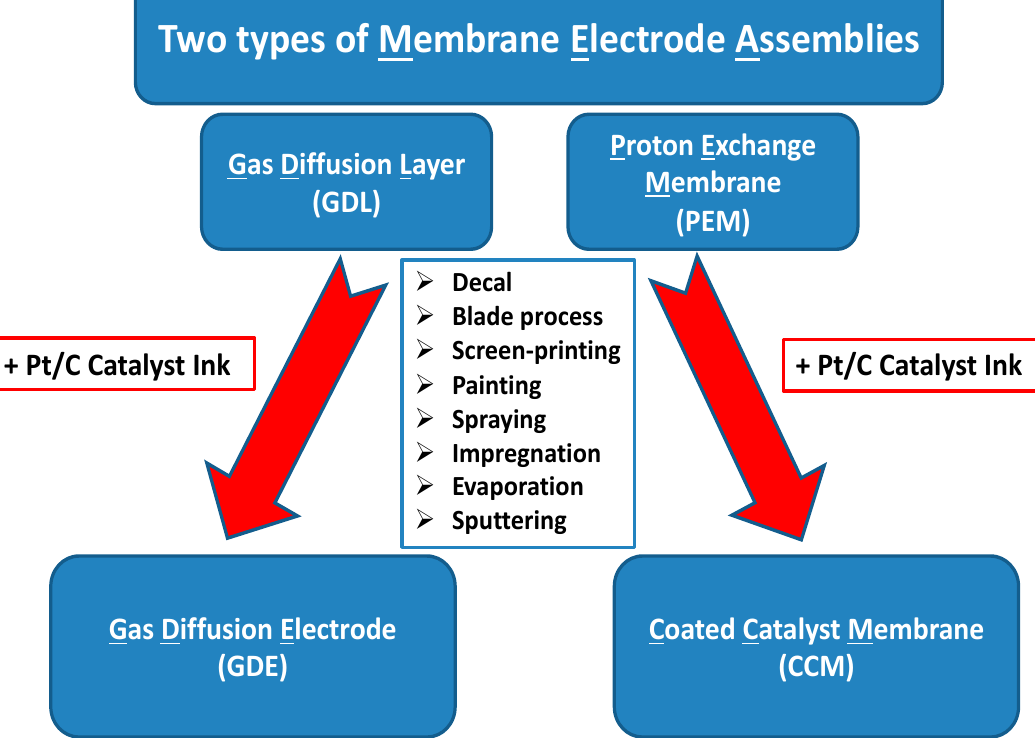
Figure 13. Various preparation methods for gas diffusion electrodes (GDE) and catalyst coated membranes (CCM).